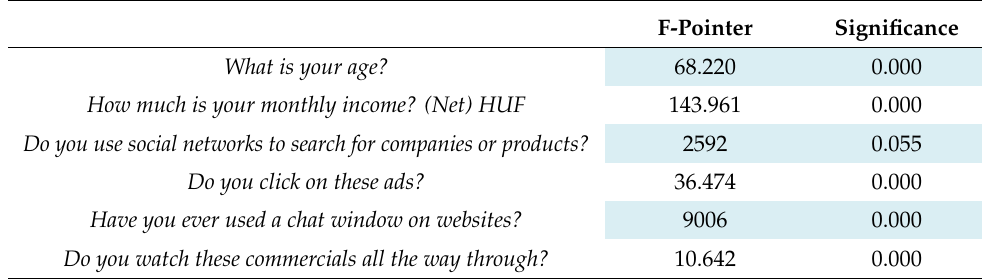
Table 3. Analysis of variance (ANOVA) table.